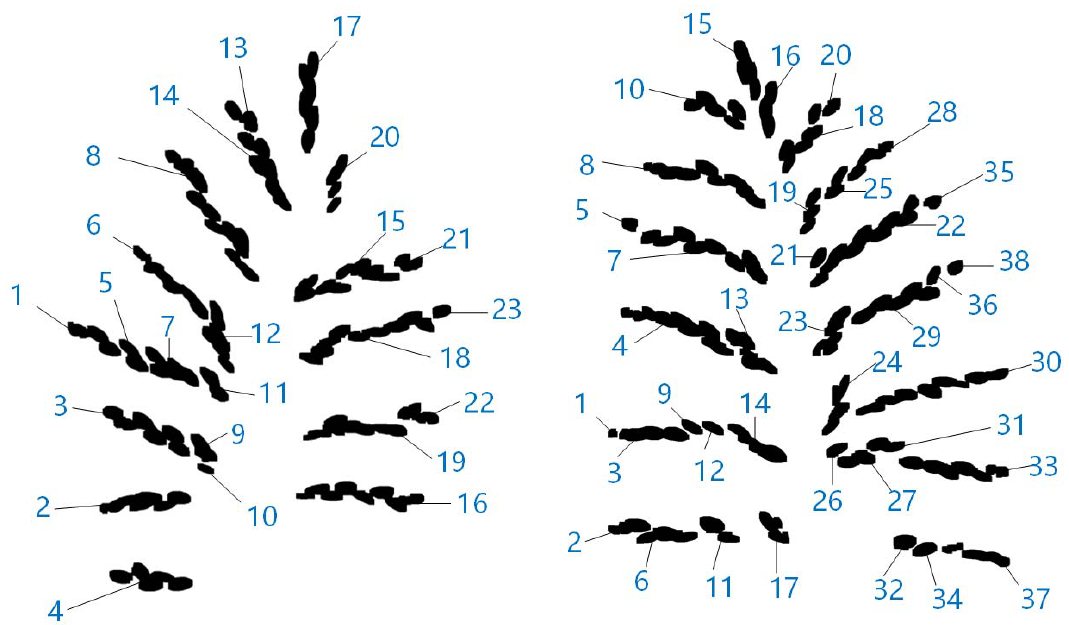
Figure 10. All connected regions of sample A ( left ) and sample B ( right ). Table 1. Results for sample A *.